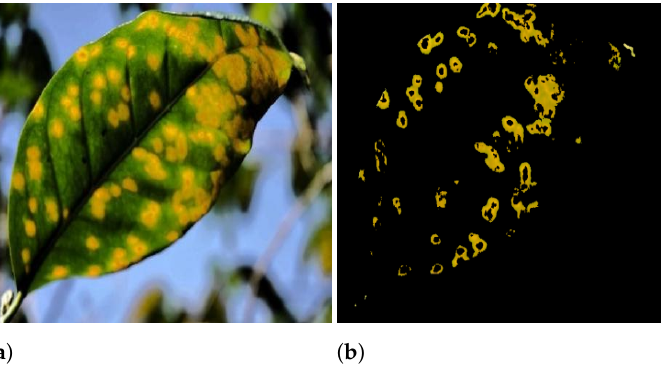
Figure 2. ( a ) leaf affected with guava rust (input image), ( b ) diseased area